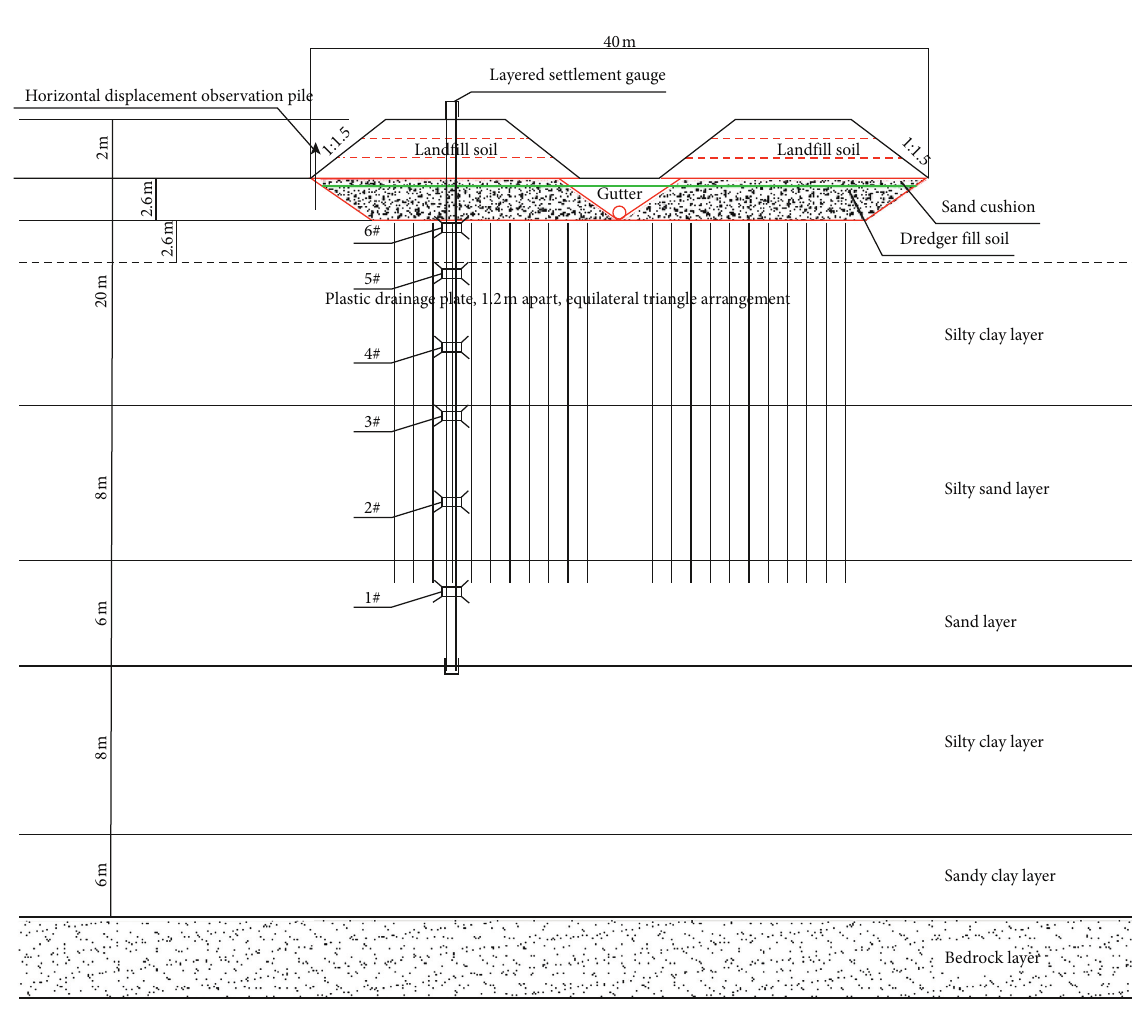
Figure 1: Simplified soil layer distribution (not to scale). Table 1: Physicomechanical parameters of